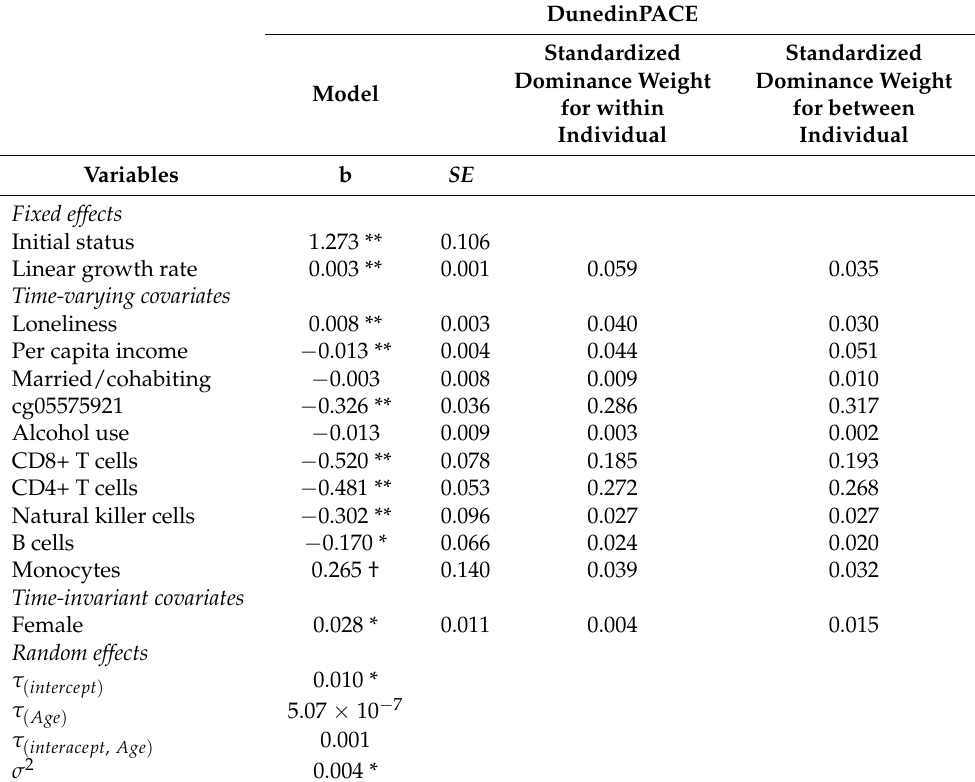
Table 4. Dominance analysis and parameter estimates for linear growth models with time-varying and time-invariant covariates and cell-types ( n = 685).